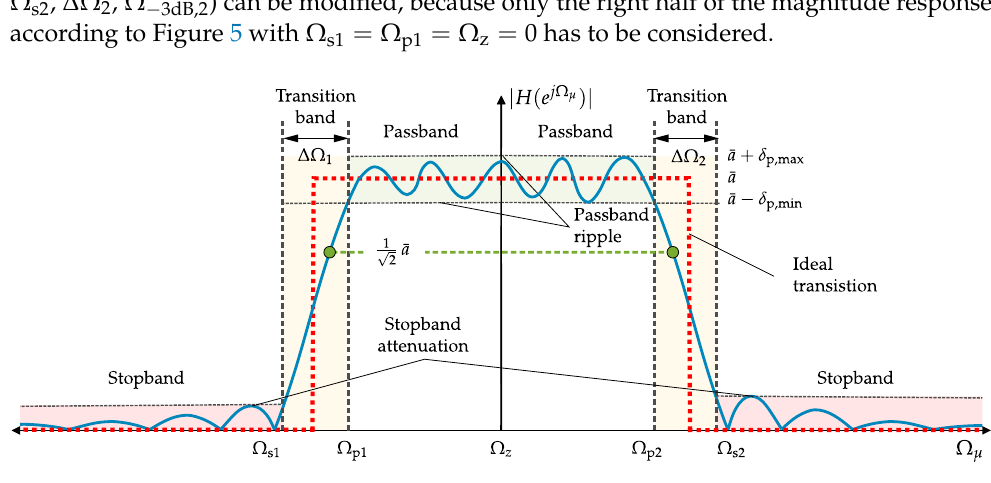
Figure 5. Amplitude response (asymmetrical passband) with predominant bandpass characteristic including metrics labeling. For a response with lowpass characteristic, only the right abscissa axis is